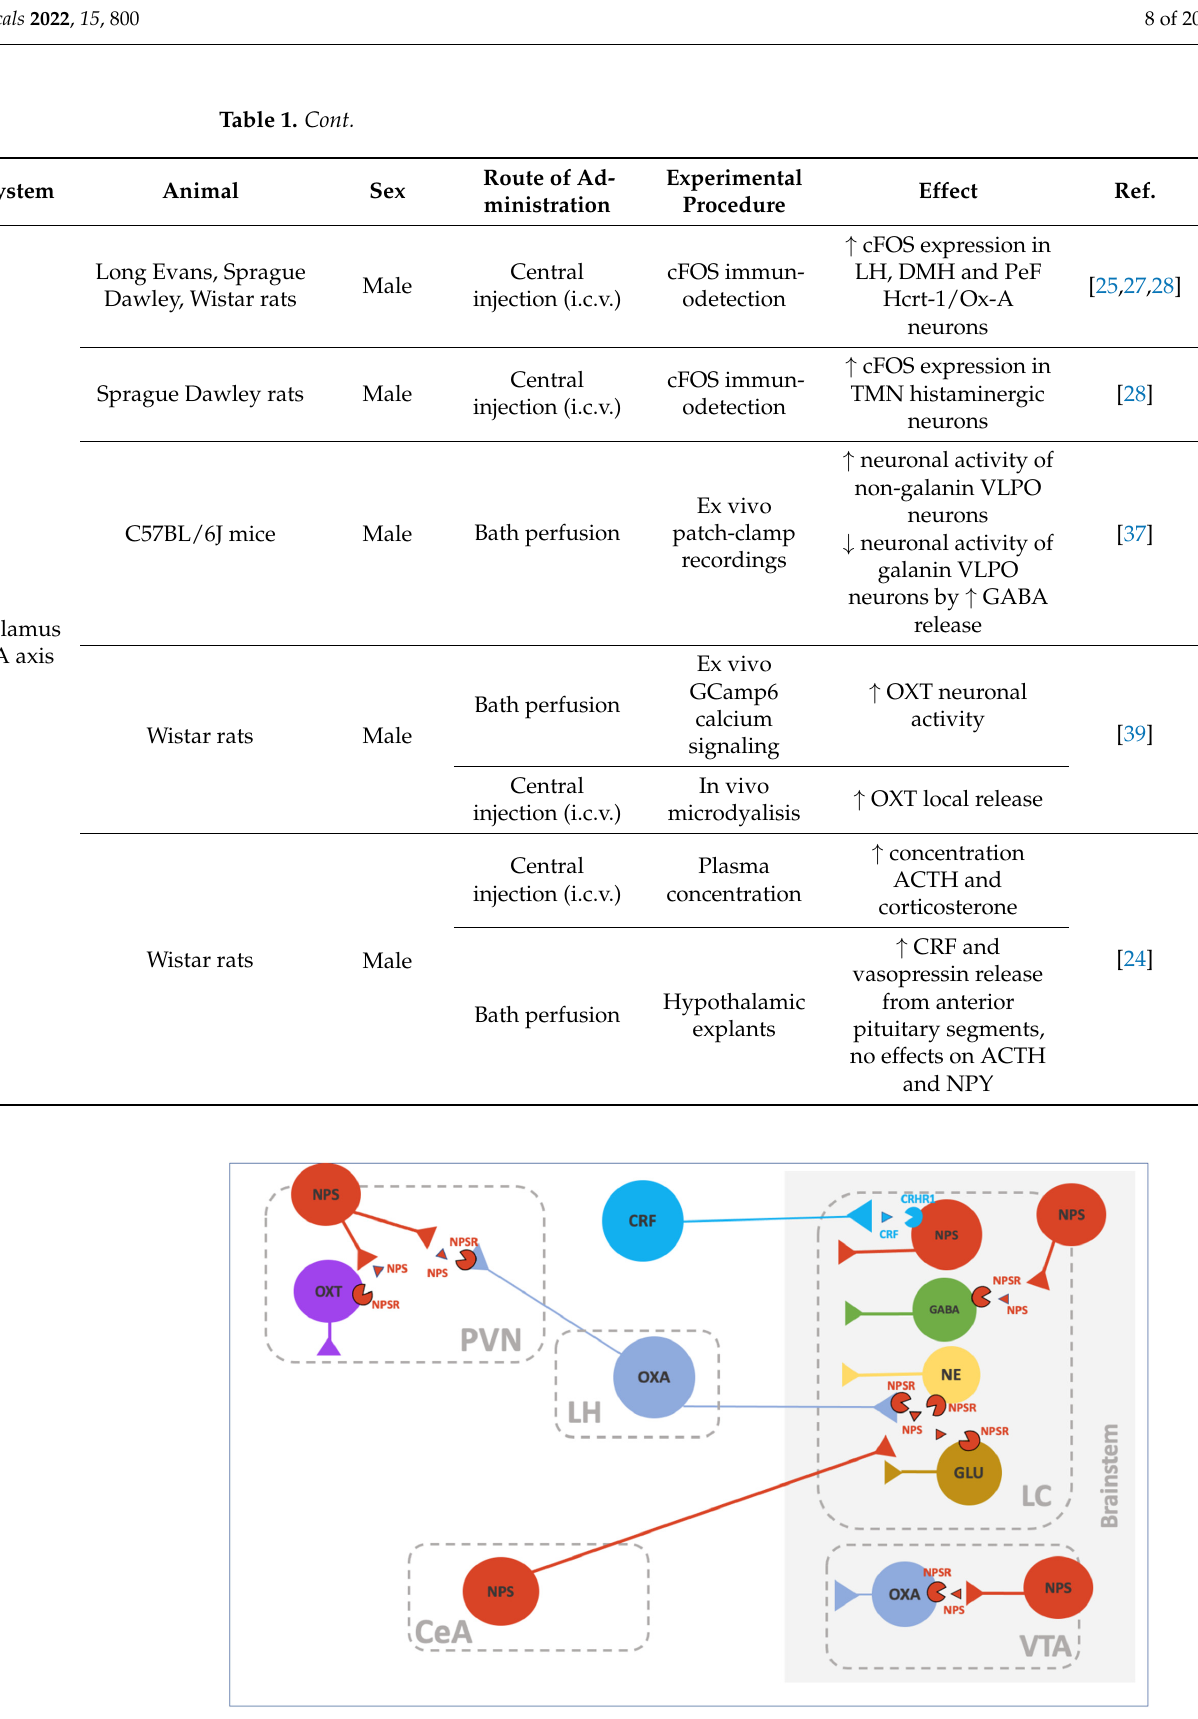
Figure 2. Schematic representation of the interaction of the NPS/NPSR system with other neurotransmitter systems. Ventral tegmental area (VTA); hypothalamic para ventricular nucleus (PVN): central amygdala (CeA); lateral hypothalamus (LH); locus coeruleus (LC).